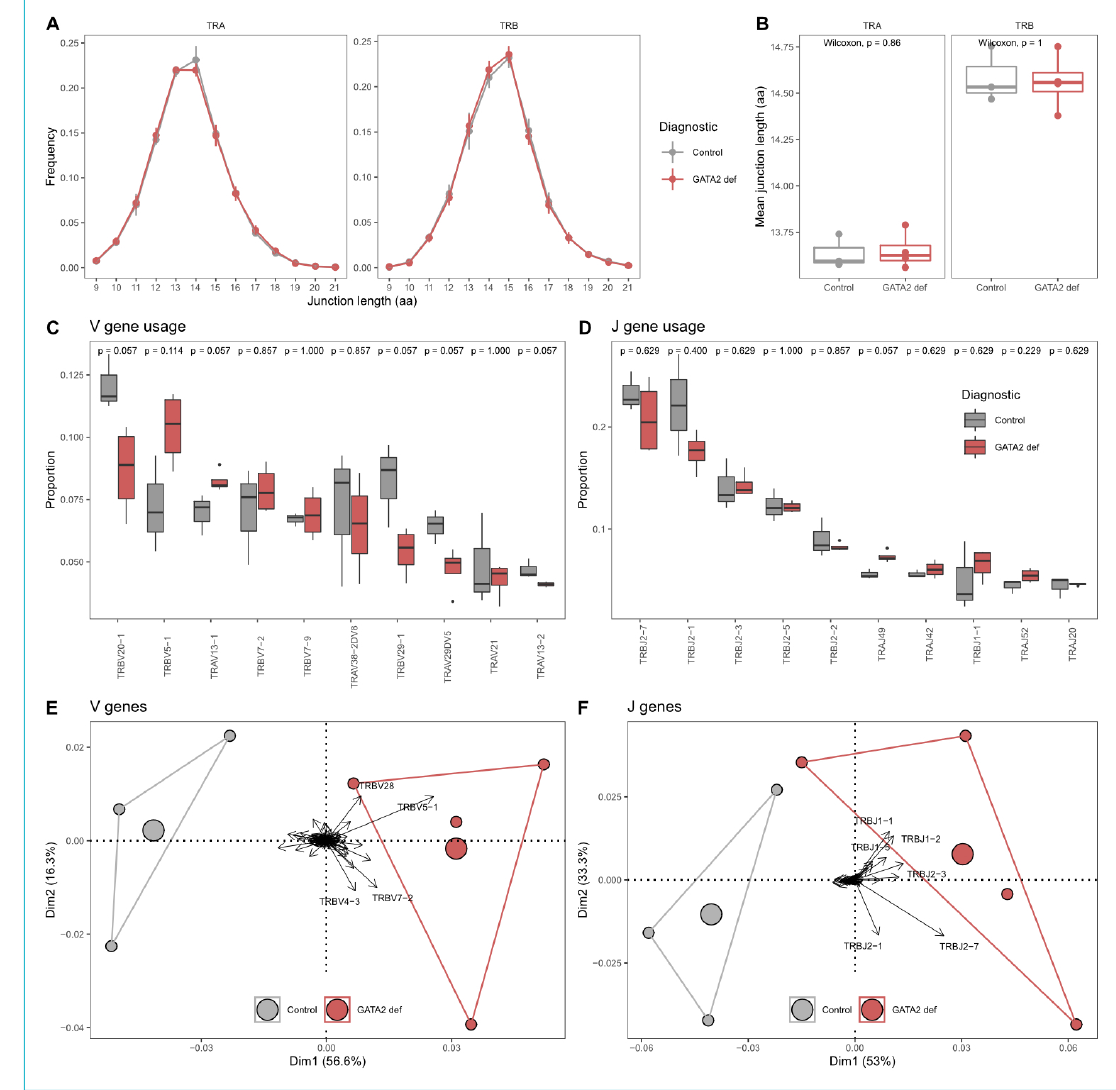
Figure 1: Comparison of TCR repertoire characteristics in GATA2 patients and healthy controls. (A) CDR3 junction length (amino acids) distri- butions in both clonal chains. (B) Comparison of mean CDR3 junction length. (C) Comparison of V gene and (D) J gene usage. Shown are the ten most frequently used genes respectively. Pairwise comparisons performed using the Wilcoxon test. Group size: GATA2 def = 4, Control = 3. (E) Principal component analysis by diagnosis including usage of all V genes and (F) J genes. Areas are the convex hulls of the diagnostic group and the largest point of one colour represents the centre of that hull. Arrows show contributions of individual input variables, only strongest contributors are